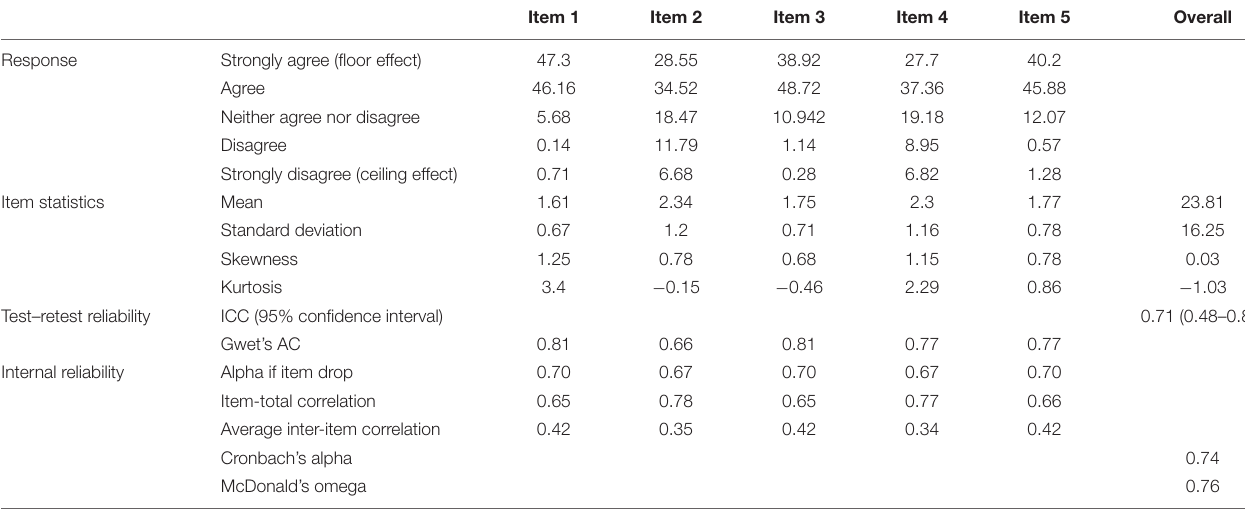
TABLE 3 | The item statistics and reliability of